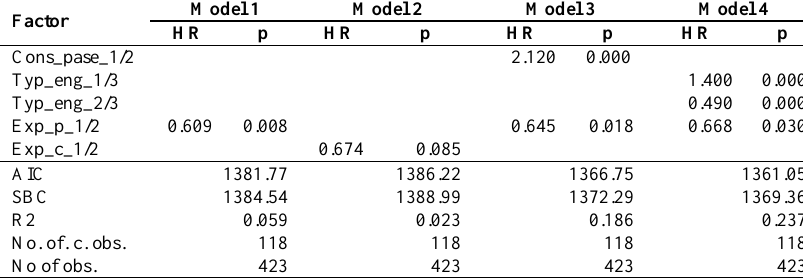
Table 2. Results for Cox proportional hazard models, α